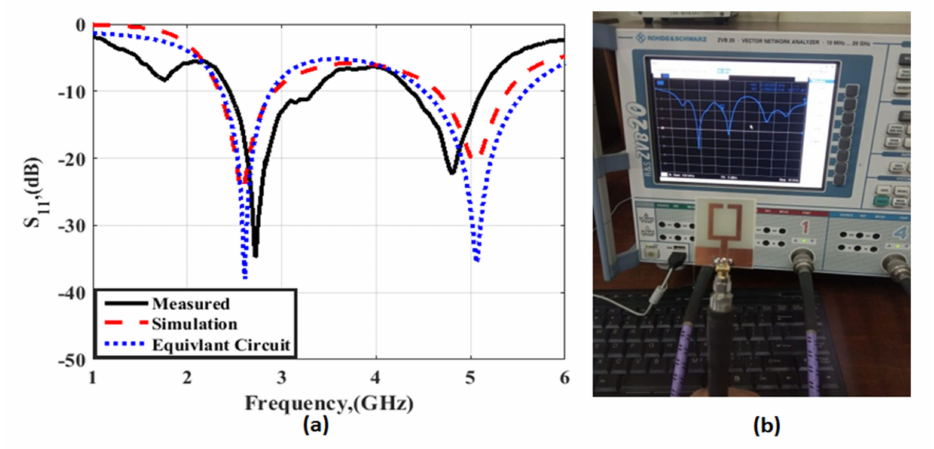
Figure 4. The CPW dual − band monopole antenna: ( a ) Simulated, equivalent circuit, and measured S 11 results; ( b ) measured S 11 results with